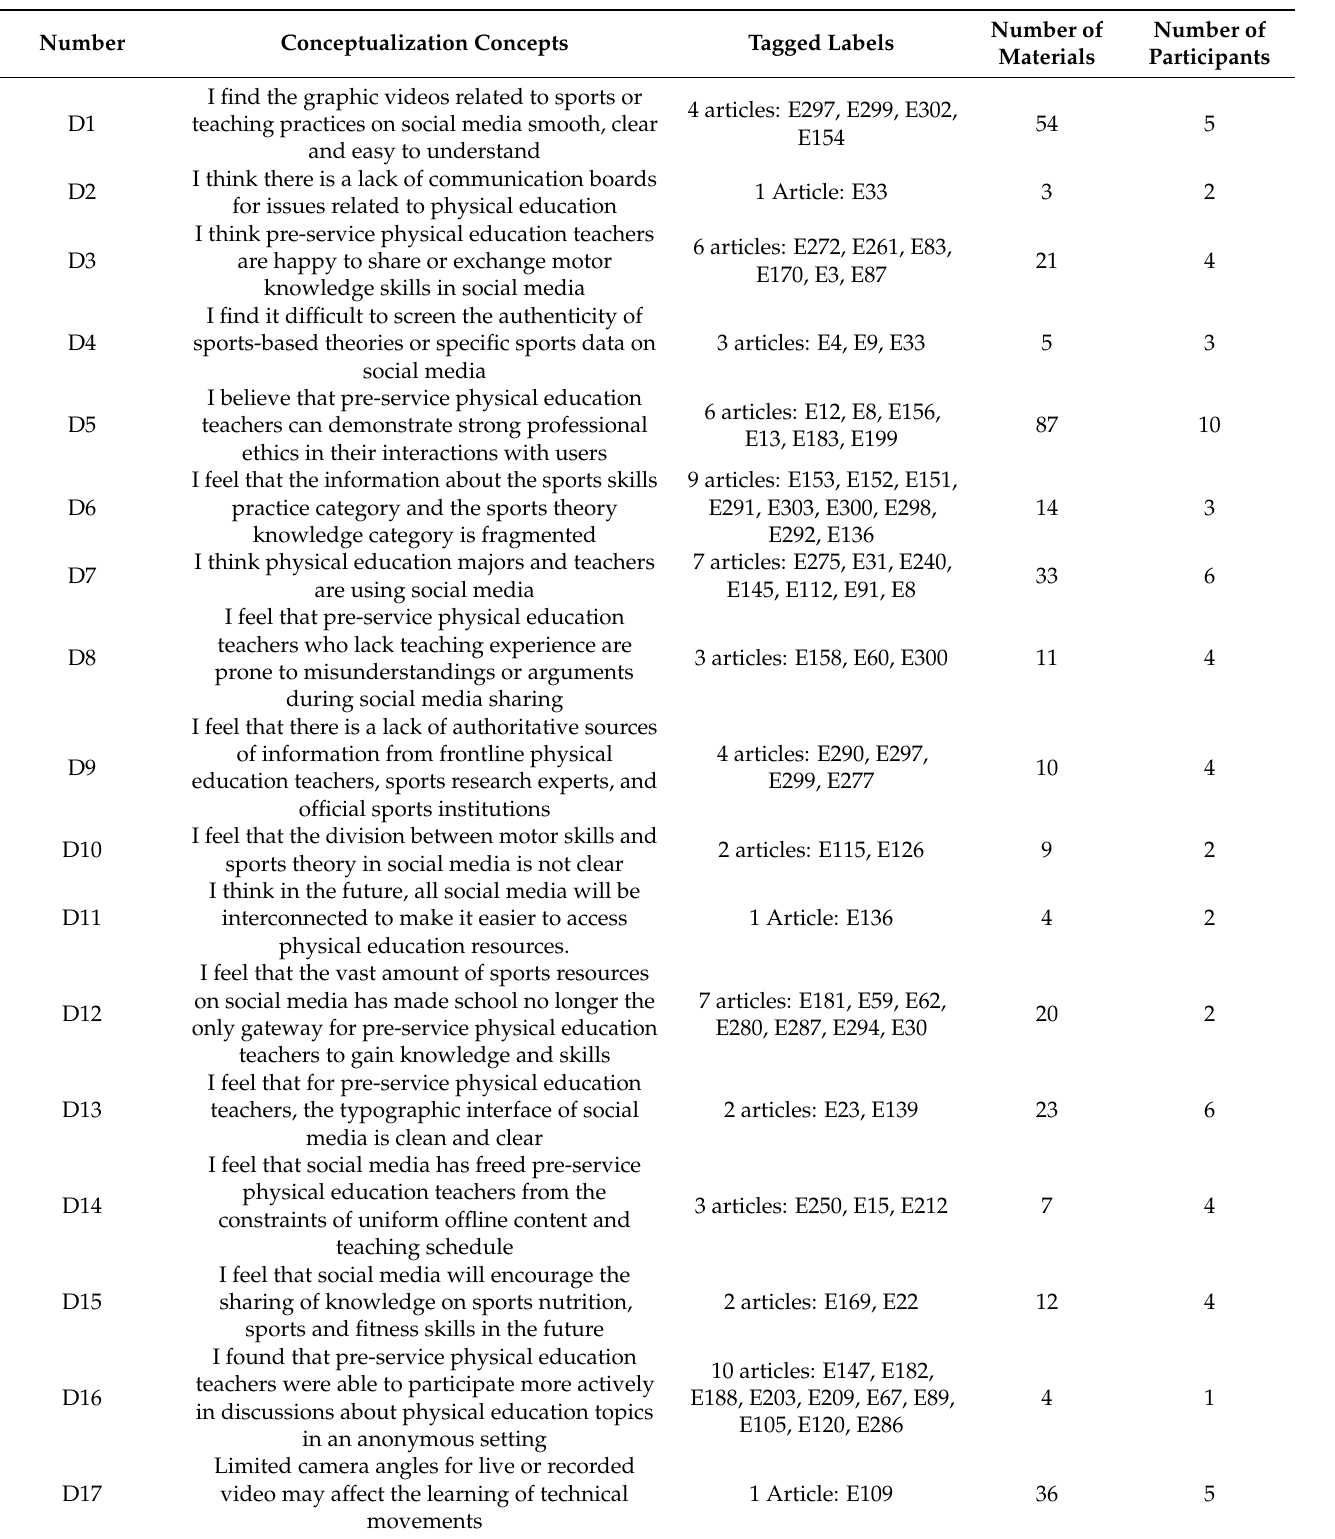
Table A2. Conceptualization results of 307 tagged